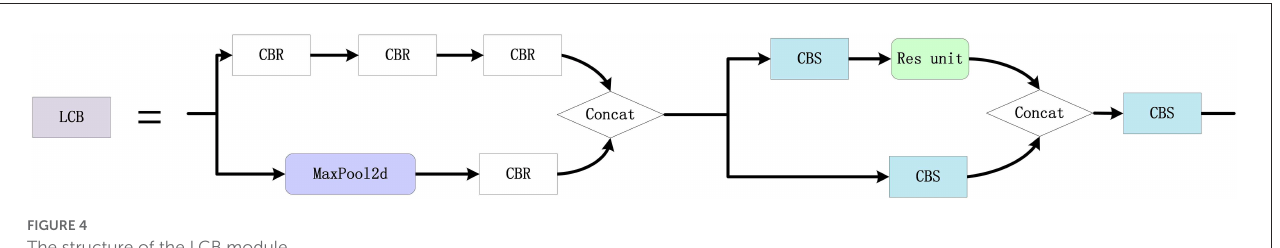
FIGURE4 The structure of the LCB module.